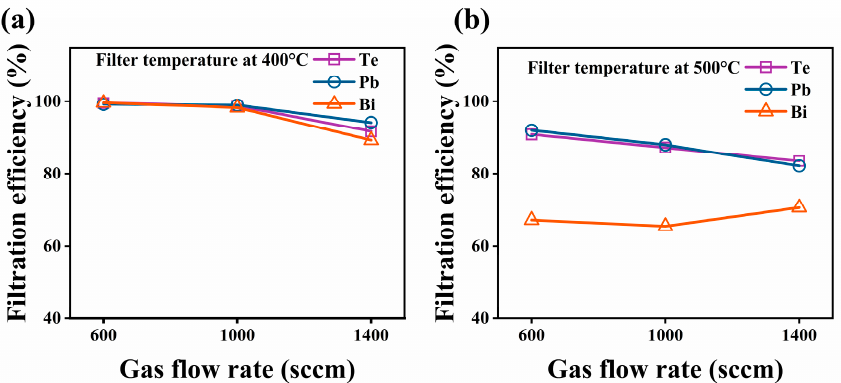
Figure 7. Filtration efficiencies of the SNF for Te, Pb, and Bi at different gas flow rates at filtration temperatures of ( a ) 400 °C and ( b ) 500 °C.